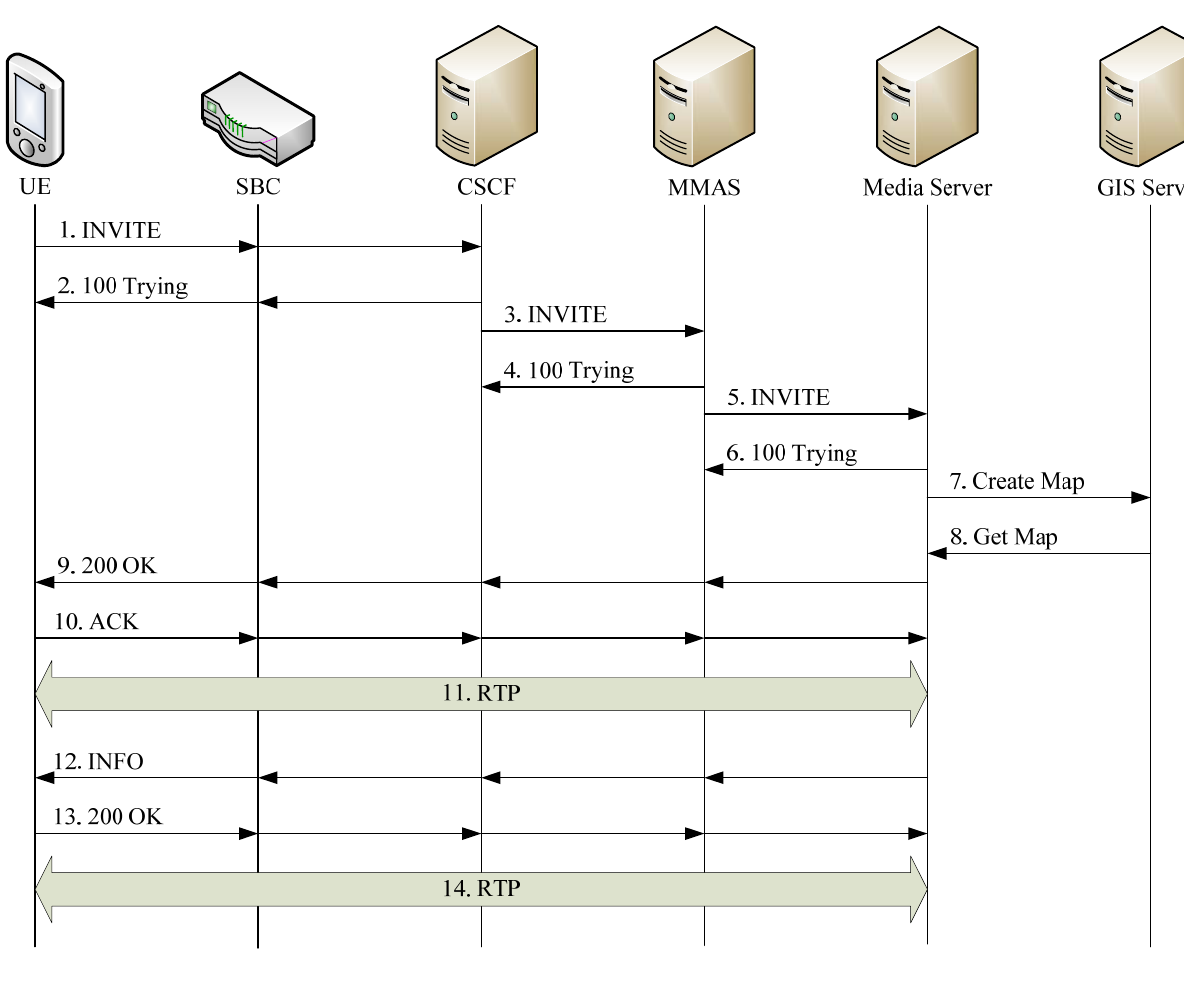
Figure 4. Location Information Message